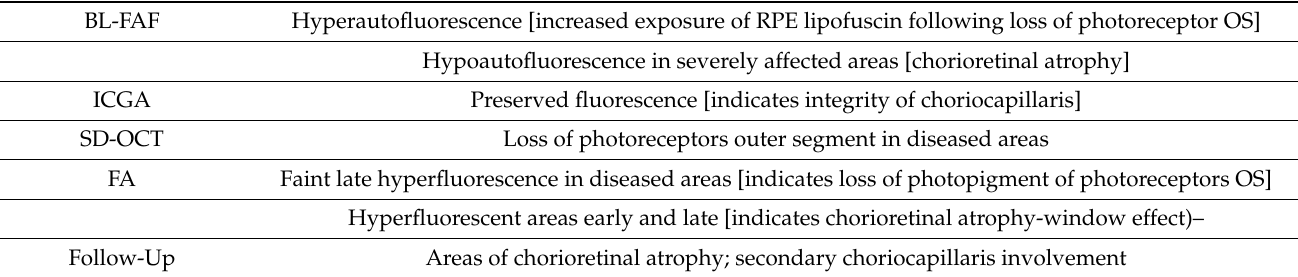
Table 2. Multimodal imaging of AZOOR and clinicopathological